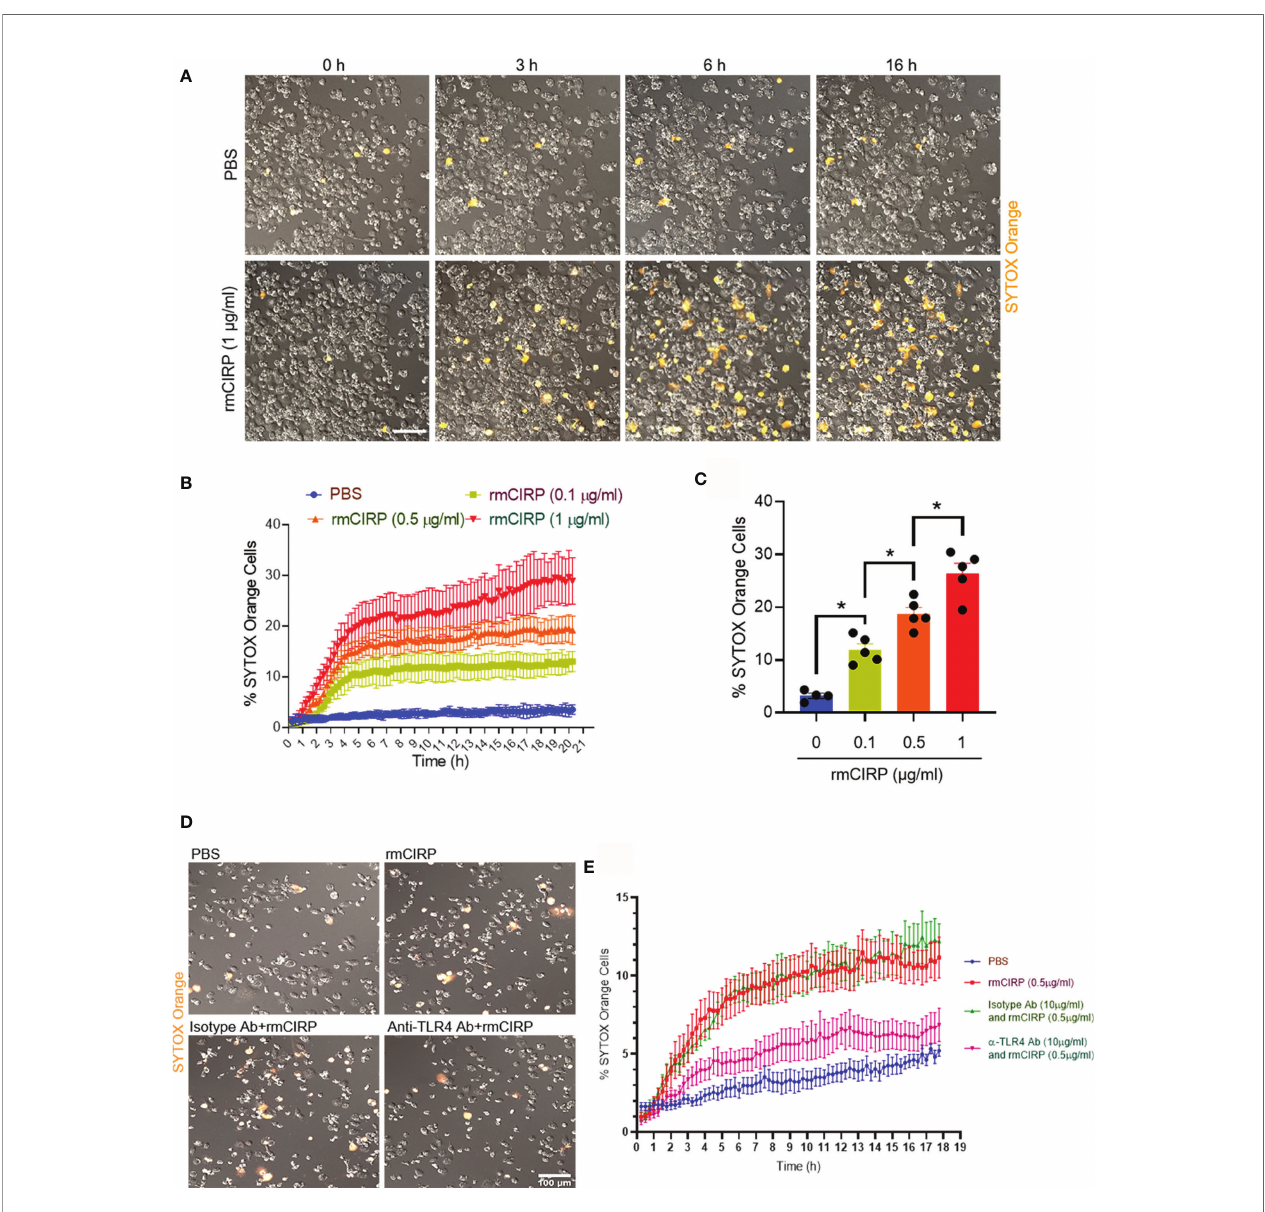
FIGURE 1 | eCIRP induces extracellular trap formation in THP-1 cells. (A) THP-1 cells were treated with PBS or rmCIRP (1 µg/ml) in the presence of SYTOX Orange (0.6 µM) and subjected to the time-lapse live-cell imaging immediately after the treatment with rmCIRP. The upper panel shows the cells treated with PBS without rmCIRP, and the lower panel shows the cells treated with rmCIRP at different time points. Scale bar, 100 µm. (B) The dose-dependent effect of rmCIRP was quanti fi ed by counting the cells positive to SYTOX Orange. (C) Data shows the percentage of THP-1 cells positive to SYTOX Orange at 16 h after rmCIRP treatment (n = 4 – 5 microscopic fi elds for each condition). One-way ANOVA with Turkey method: *p <0.05. (D) THP-1 cells were pre-treated with IgG isotype Abs (10 µg/ml) or anti-TLR4 Abs (10 µg/ml) for 30 min. These cells were then treated with PBS or rmCIRP (0.5 µg/ml) in the presence of SYTOX Orange (0.6 µM) and subjected to the time-lapse live-cell imaging immediately after the treatment with rmCIRP. The time-lapse live-cell imaging data were acquired up to 18 h. The representative microscopic images taken at 18 h of rmCIRP treatment are captured and shown. Scale bar, 100 µm. (E) The percentages of SYTOX Orange positive cells in various experimental groups with time are